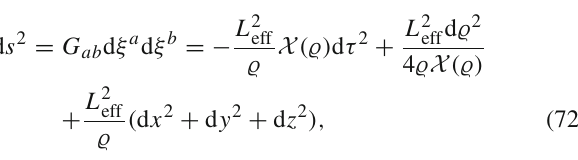
ture, which became deeper with decreasing the